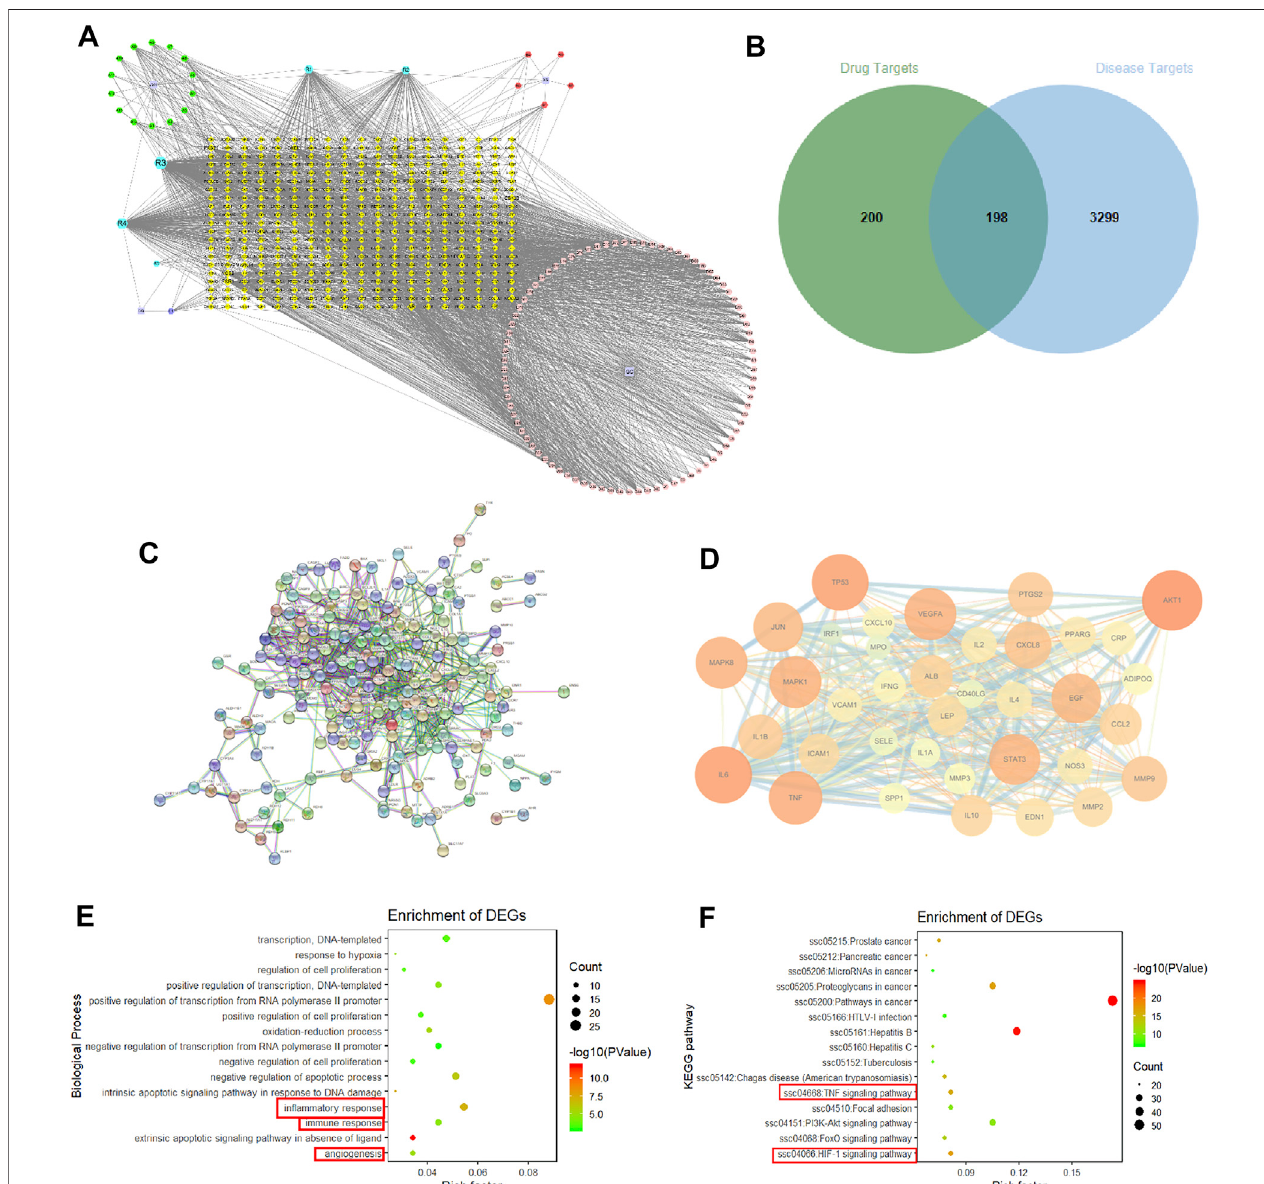
FIGURE3| Networkpharmacology. (A) Drugs – compounds – targets network. Thenode representing thecompound isrepresentedbyamulti-color hexagon, and the target point is represented by a yellow diamond. (B) Venn diagram. (C) PPI network. (D) PPI network of core targets extracted from degree centrality. (E) GO enrichment analyses. A total of 15 biological process items in descending order of p -values in the DAVID database. (F) KEGG enrichment analyses.